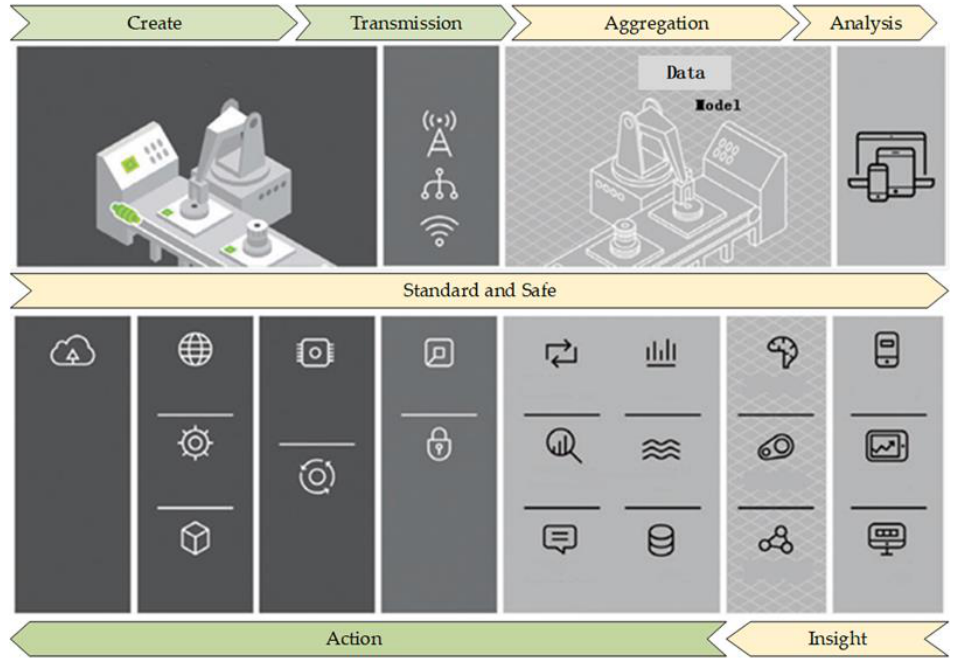
Figure 2. Digital Twin Conceptual Architecture [1].